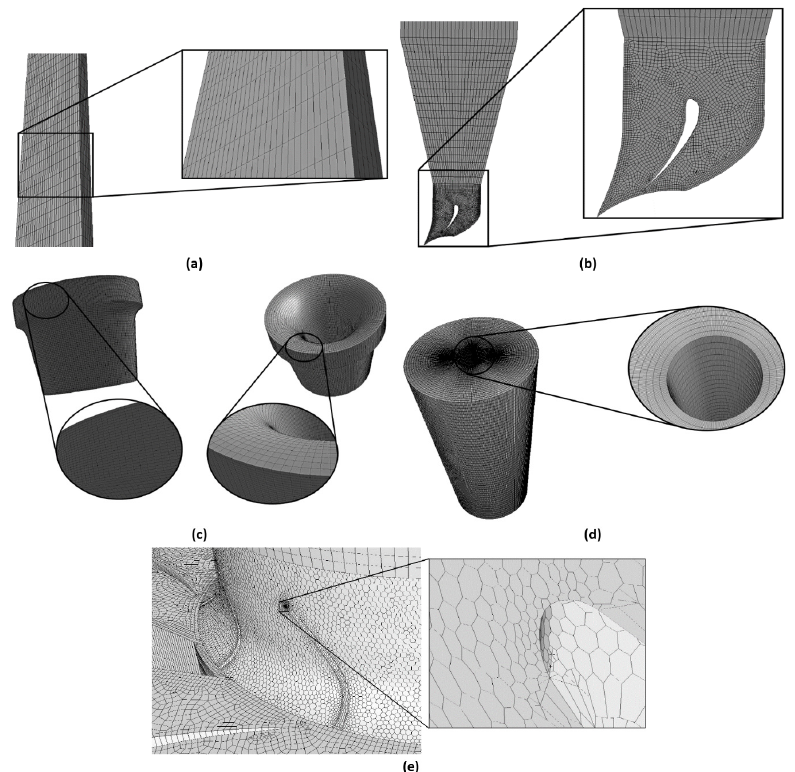
Figure 3. Mesh generated on: ( a ) exhaust pipe, ( b ) 1st stage nozzle vane, ( c ) diffusor, ( d ) outlet, ( e ) 1st stage rotor.